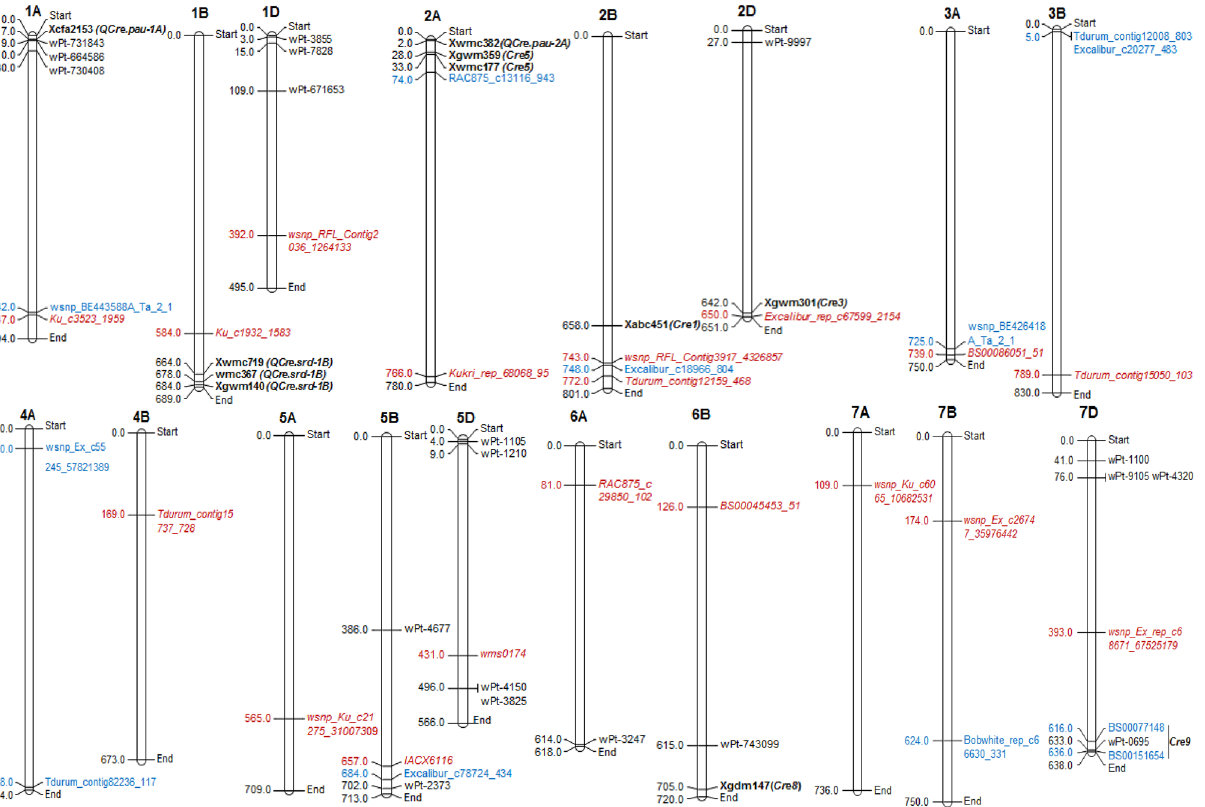
Figure 4. Chromosome maps showing QTLs detected in the present study and genes/QTLs/MTAs of H. avenae and H. filipjevi reported in the previous studies. Out of 19, 18 QTLs could be shown in the maps. QCcn.ha-4A could not be shown as suitable hits was not found. The markers associated with QTLs detected in the present study are depicted in red italicized font. Previously reported genes and QTLs for H. avenae are shown in black coloured bold font with associated markers shown in italicized font. Previously reported MTAs for H. avenae are shown in normal black font. Previously reported MTAs for H. filipjevi are shown in normal blue